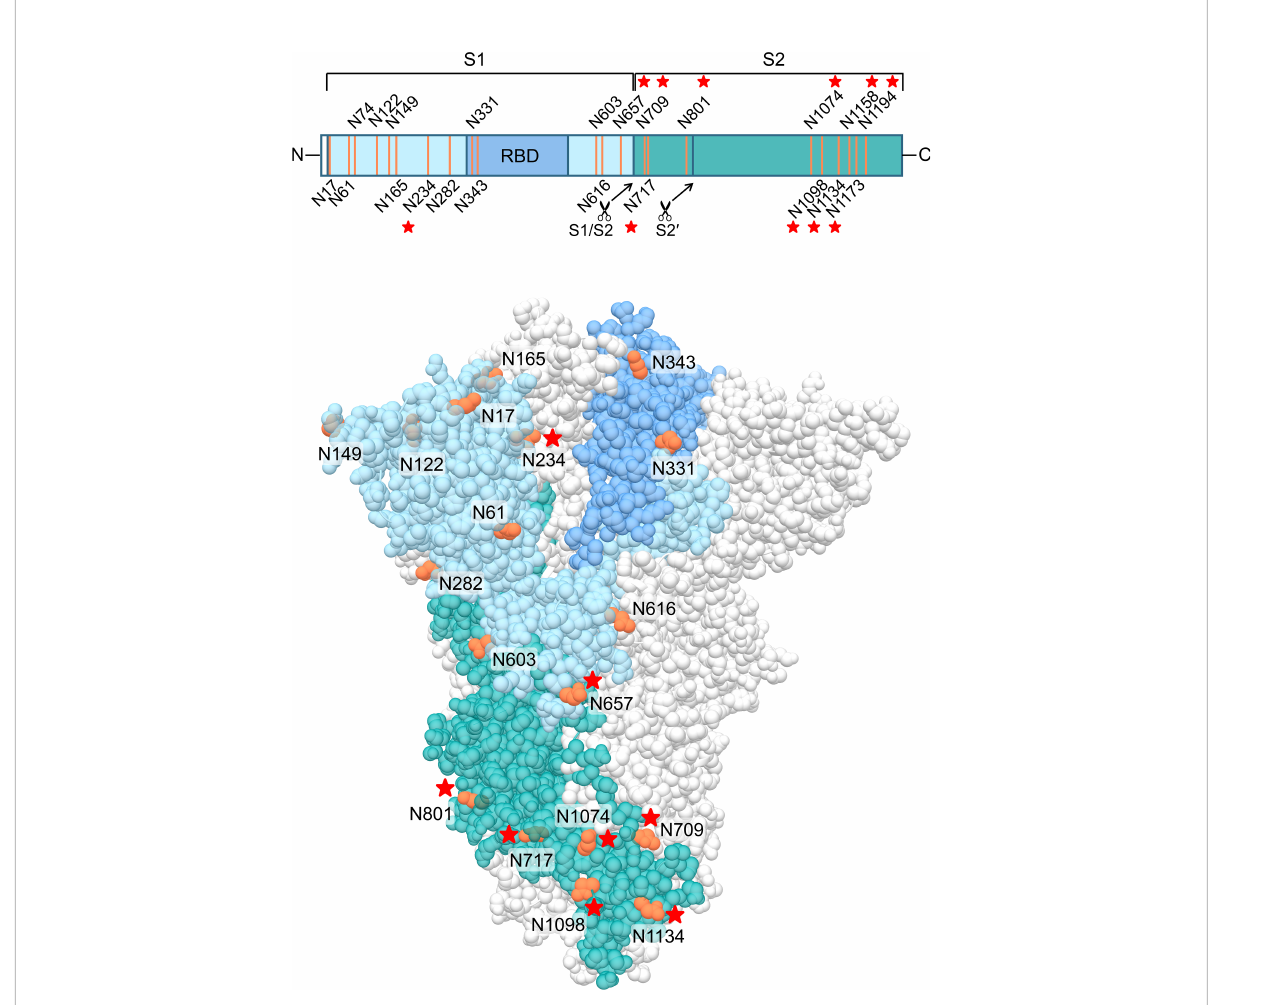
FIGURE 6 Structure of the SARS-CoV-2 spike trimer, based on PDB 6ZGE (Wrobel et al., 2020). One monomer is coloured, in blue (S1 subunit; with RBD in darker blue) and dark cyan (S2 subunit), with the N-glycosylation sites in orange. The stars indicate the N-glycosylation sites which were deleted in this study. Four N-glycosylation sites (i.e., N74, N1158, N1173 and N1194) were unresolved in the cryoEM structure. Image created with UCSF Chimera (Pettersen et al.,